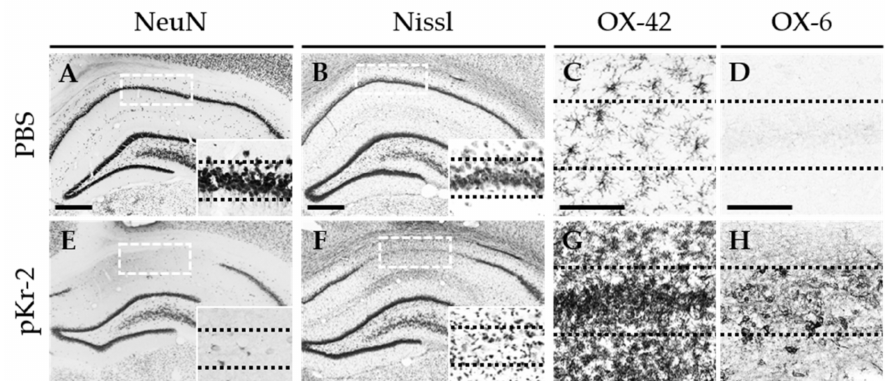
Figure 1. Prothrombin kringle-2(pKr-2) induces neurodegeneration and activation of mi- croglia/macrophages and neutrophils in the CA1 area of the hippocampus in vivo. PBS ( A – D ) as a control or prothrombin kringle-2 (pKr-2; E – H ; 48 µ g/ µ L) was unilaterally injected into the CA1 layer of rat hippocampus. Animals were transcardially perfused and brains were prepared for immunohistochemical staining at 7 days after pKr-2 injection. Every sixth serial section was immunostained for NeuN (neuronal nuclei), Nissl, OX-42 (complement receptor 3, CR3) or OX-6 (major histocompatibility complex class II, MHC II). ( A , E ) NeuN immunostaining to identify neu- rons in the CA1 layer of hippocampus. Scale bar, 500 µ m. ( B , F ) Nissl substance was stained in the CA1 layer of hippocampus. Scale bar, 500 µ m. ( C , G ) OX-42 immunostaining to identify mi- croglia/macrophages and neutrophils in the CA1 layer of hippocampus. Scale bar, 100 µ m. ( D , H ) OX-6 immunostaining to identify activated microglia. Scale bar, 100 µ m. Note the morphological changes of microglia/macrophages and neutrophils from resting state (small and ramified) to acti- vated state (large, short, and thick) in the pKr-2-injected CA1 layer of hippocampus, compared with the PBS-injected control. Insets are magnified from rectangles ( A , B , E , F ). Dotted lines indicate the CA1 layer of the hippocampus ( A – H